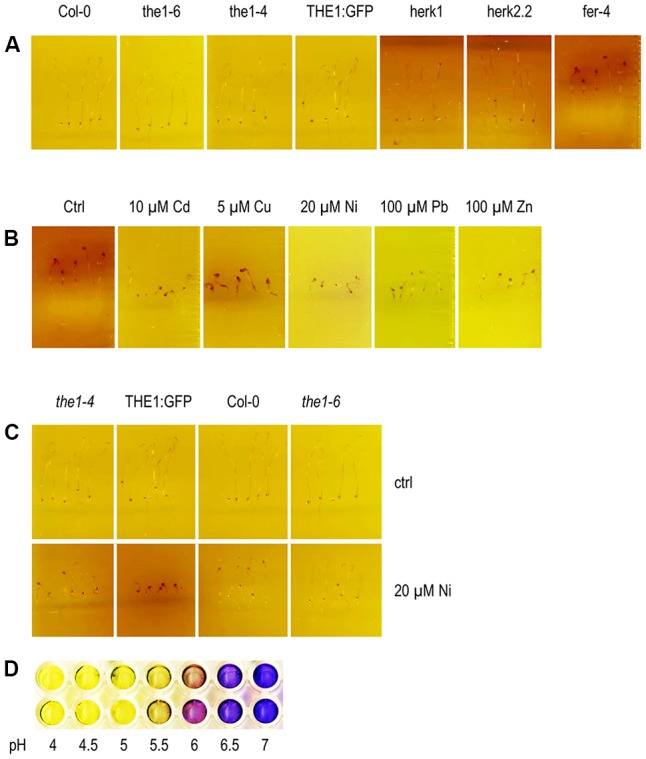
Alkalinization of the medium around etiolated hypocotyls. (A) On control medium, (B) of fer-4 on metal ions and (C) of loss- and gain-of-function alleles of THE1 on elevated Ni concentrations. (D) BCP is yellow below pH < 5.2 and purple above pH > 6.0. The contrast and brightness of the pictures were increased by 50% and 20%, respectively, except for fer-4 on Pb where only the contrast was raised to +50%.